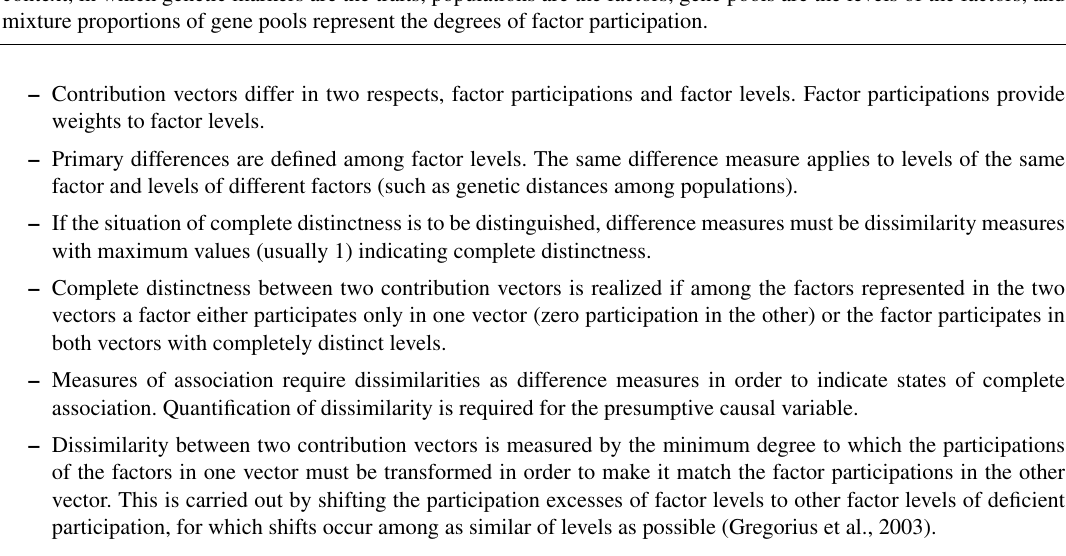
Table 1. Measuring dissimilarity among contribution vectors. For illustration purposes the following examples of measuring dissimilarity could be viewed in a population genetic context, in which genetic markers are the traits, populations are the factors, gene pools are the levels of the factors, and mixture proportions of gene pools represent the degrees of factor